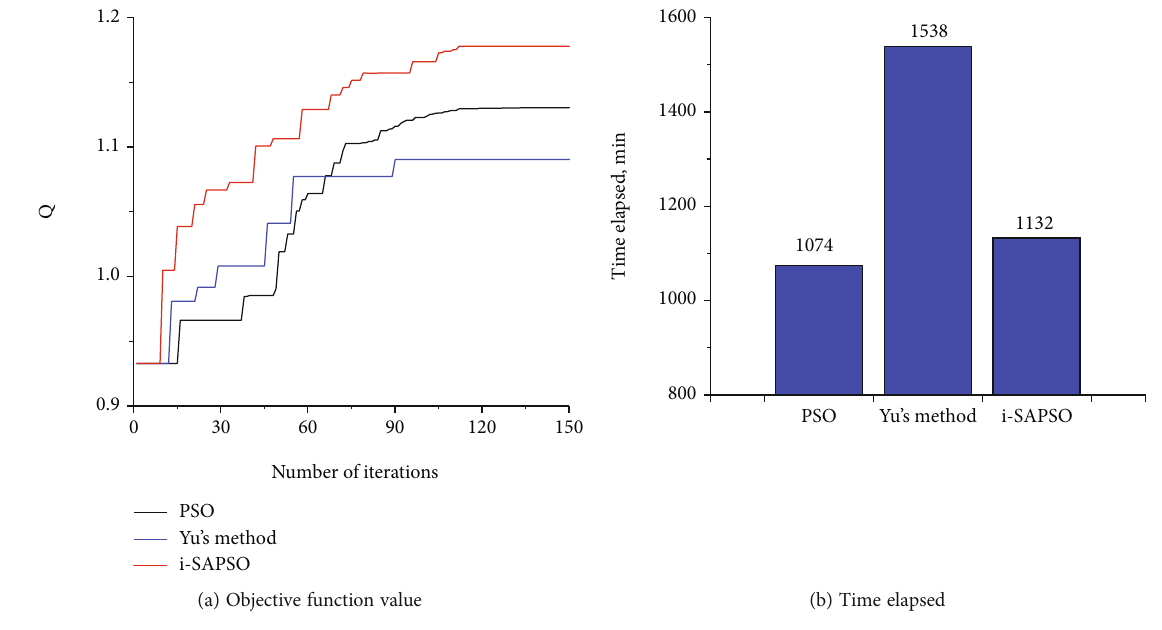
Figure 5: Performance comparison of di ff erent methods.